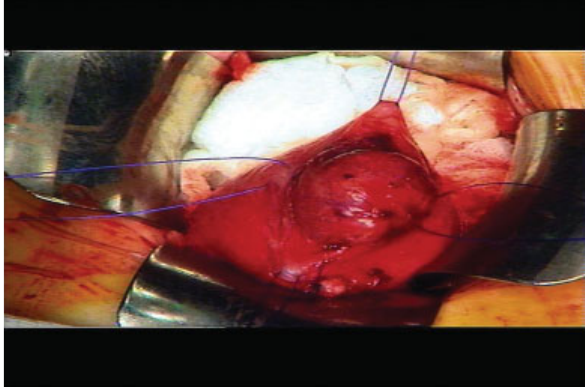
Fig. 2 Intraoperative view of the urinary bladder